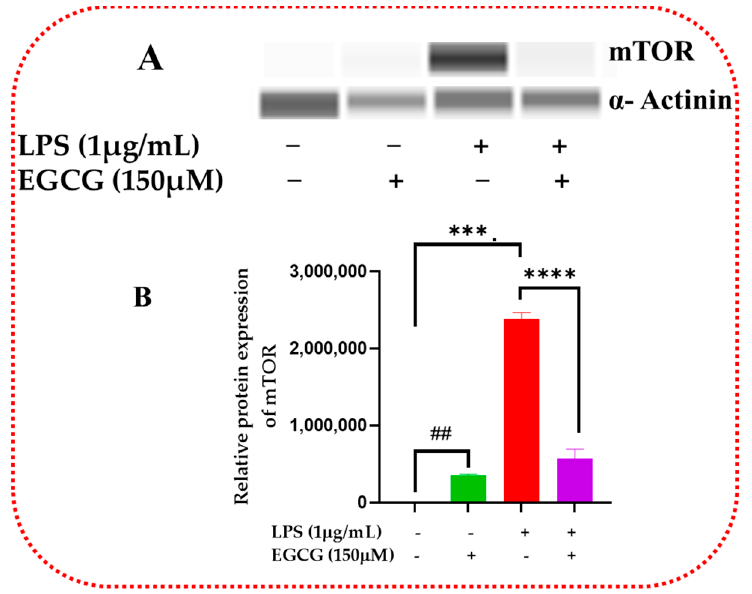
Figure 17. EGCG a tt enuated relative protein expression of mTOR. Western blot representative im- age of mTOR assessment displayed that EGCG 150 µM coupled with LPS 1 µg/mL, shown in bands in ( A ) and graph in ( B ), reduced protein expression of the analyte as mentioned above compared to LPS. EGCG 150 µM showed a decrease of mTOR protein expression. α -Actinin was used as loading control. Values represent the mean ± SD, *** p ≤ 0.001, and **** p ≤ 0.0001 vs. LPS, ## p <0.01 vs. control.